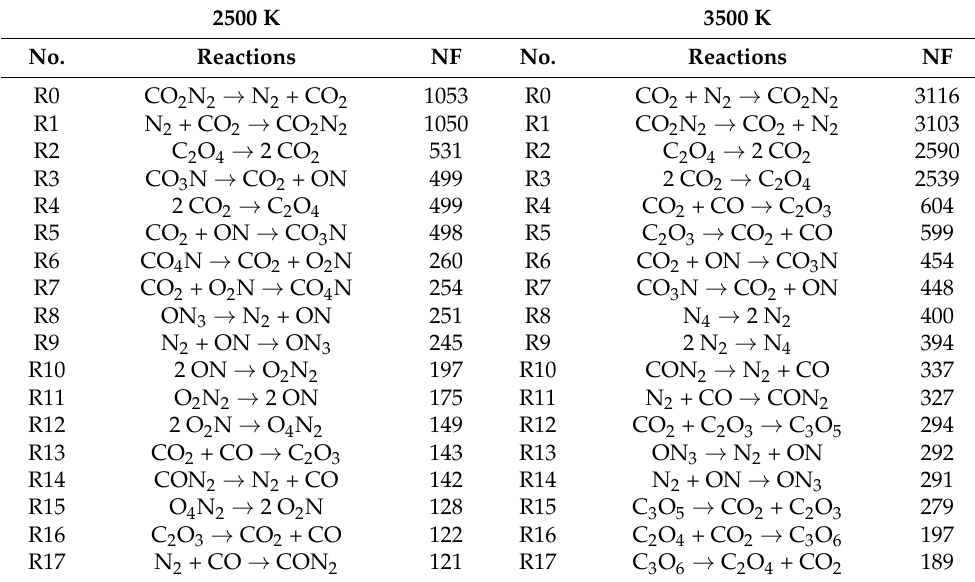
Table 4. Elementary reactions and net flux